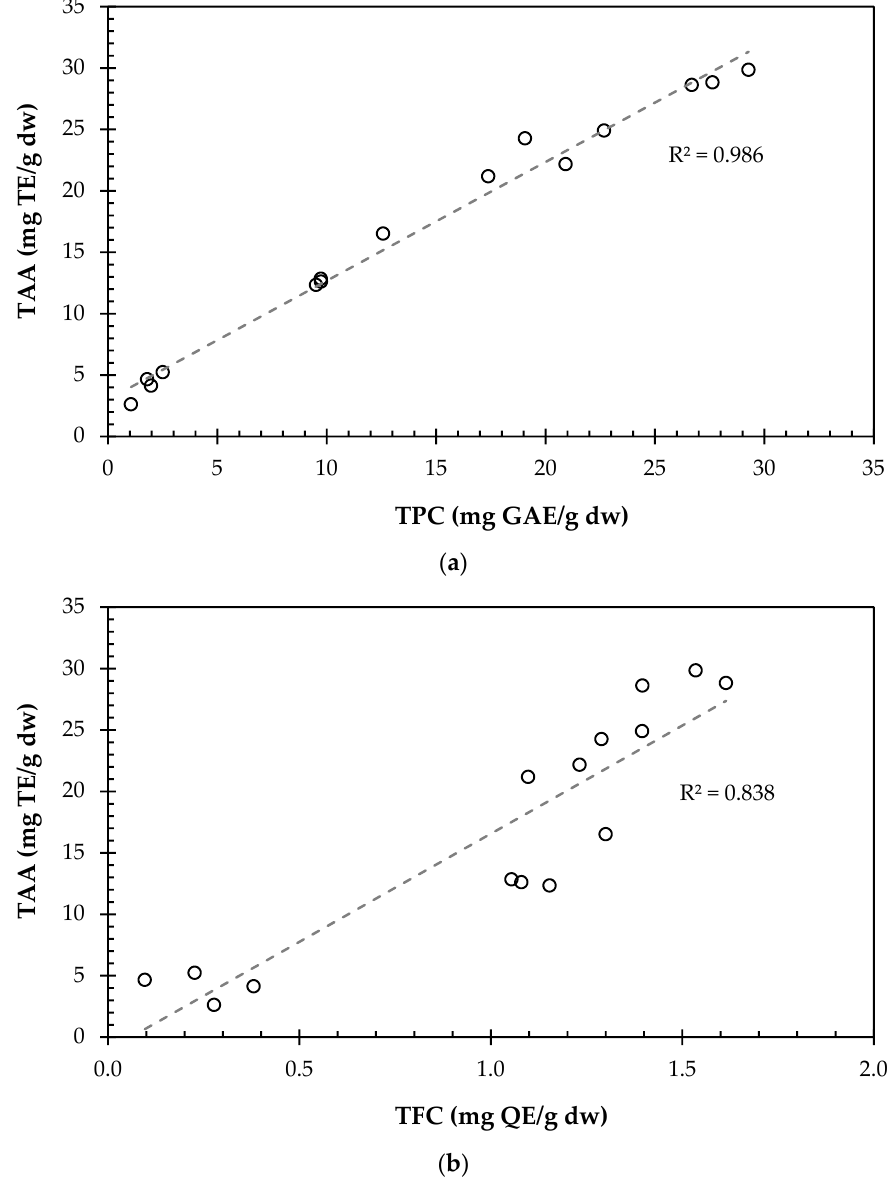
Figure 1. Correlation of TPC ( a ) and TFC ( b ) values with the TAA for the conventional extraction.